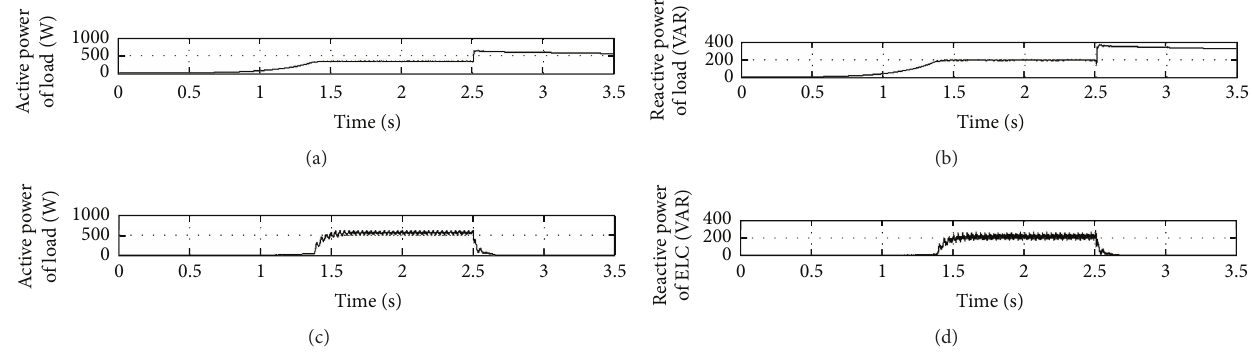
Figure 8: (a) Active power of load. (b) Reactive power of load. (c) Active power of ELC. (d) Reactive power of ELC.